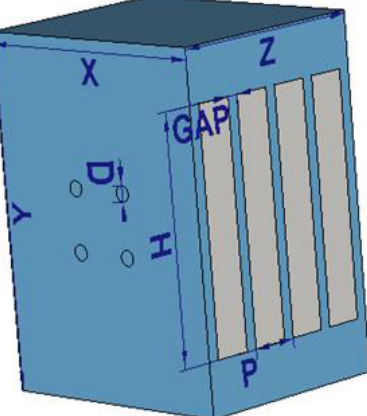
Figure 2. RF cavity considered for simulation: ladder-type multibeam EIK intermediate cavity.